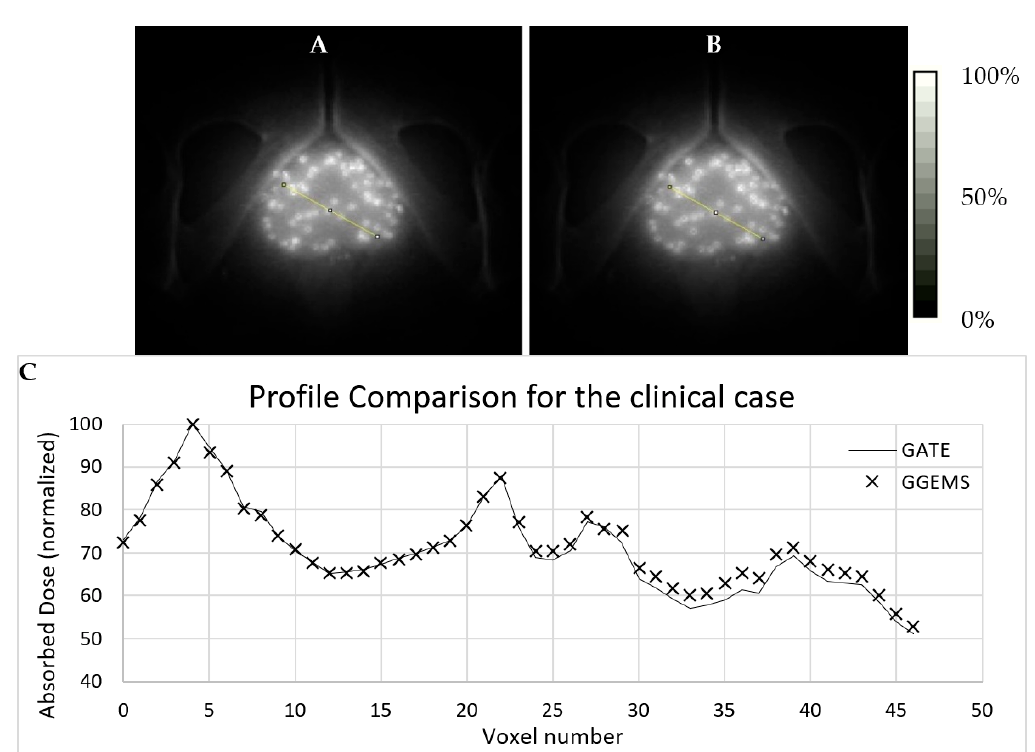
Figure 7. Simulation of a clinical case with 67 Amersham Health 6711 seeds in a prostate. Dose maps are shown for both toolkits ( A ) GATE and ( B ) GGEMS. White stands for maximum absorbed dose (100%). In ( C ) a profile comparison is depicted for both simulation tools. The line seen on ( A ) and ( B ) images is the region where the dose profile is taken.